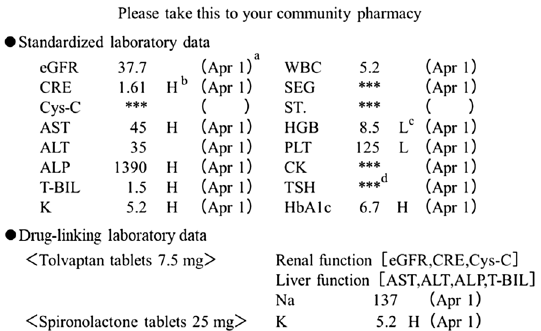
Figure 1. Example of laboratory data on an outpatient prescription. The laboratory data listed on the prescription are the latest data available at the time of prescription order registration. When the prescribing physician registers the prescription order, the laboratory data information is printed on a separate sheet at the same time as when the prescription is printed from the electronic medical records system. Both items are given to the patient by the prescribing physician. The patient then brings the laboratory data information and the prescription to the community pharmacy and submits them together. The symbols in the figure are as follows: ( a ) (Apr 1) indicates the measurement date. ( b ) H indicates a value higher than the reference range. ( c ) L indicates a value lower than the reference range. ( d ) *** indicates that there is no measured value within the last 100 days. Laboratory items are abbreviated as follows: eGFR, estimated glomerular filtration rate (mL/min); CRE, creatinine (mg/dL); Cys-C, cystatin C (mg/dL); AST, aspartate aminotransferase (U/L); ALT, alanine aminotransferase (U/L); ALP, alkaline phosphatase (U/L); T-BIL, total bilirubin (mg/dL); K, potassium (mmol/L); WBC, white blood cell count (× 1000/µL); SEG, segmented cell (%); ST., stab cell (%); HGB, hemoglobin (g/dL); PLT, platelet count (× 1000/µL); CK, creatine kinase (U/L); TSH, thyroid-stimulating hormone (µIU/mL); HbA1c, hemoglobin A1c (%); Na, sodium